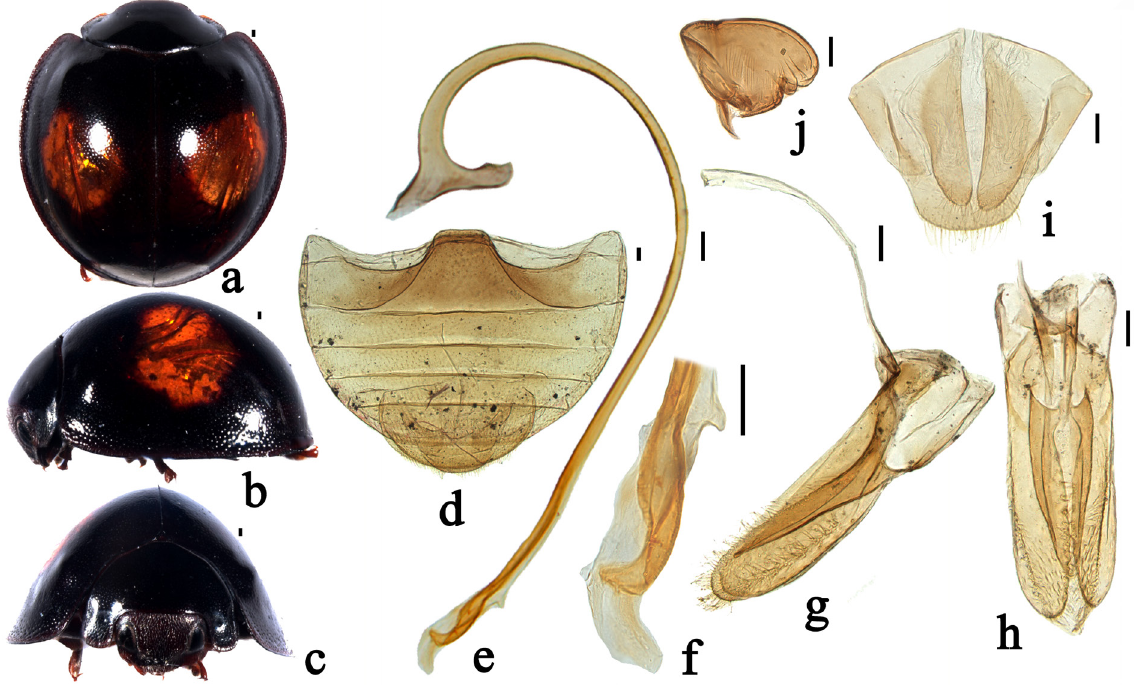
Fig. 13. Chilocorus hupehanus Miyatake, 1970. a . Dorsal view. b . Lateral view. c . Frontal view. d . Abdomen. e . Penis. f . Apex of penis. g . Tegmen, lateral view. h . Tegmen, ventral view. i–j .